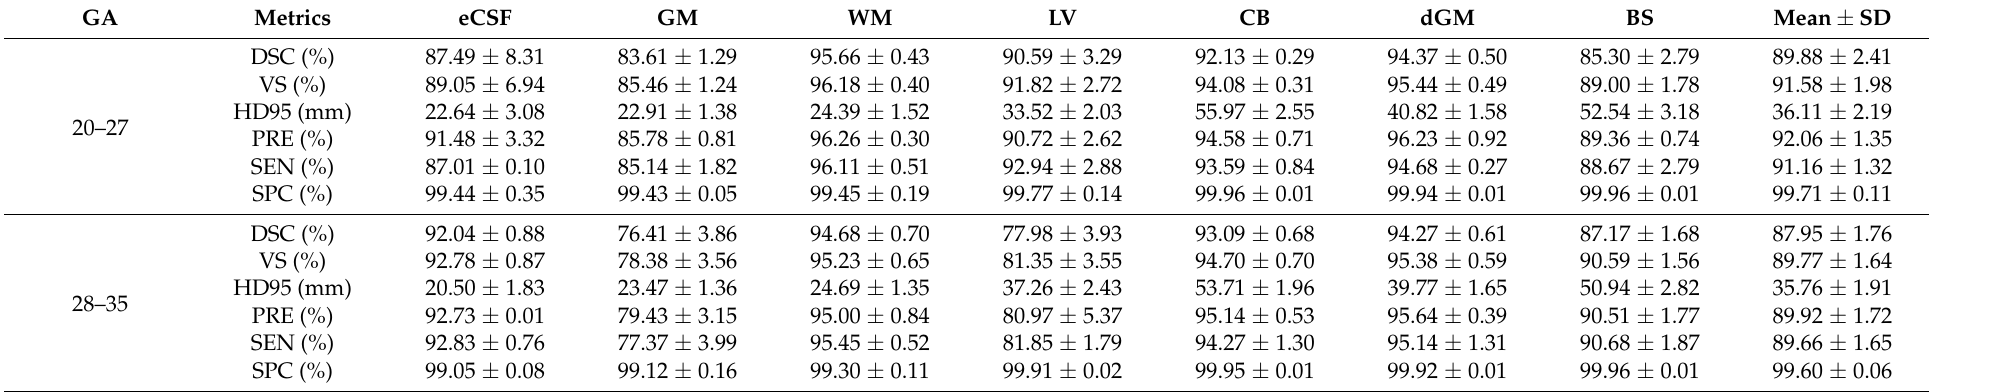
Table 3. Comparison of segmentation results of different gestational age groups (20–27 weeks and 28–35 weeks) based on quantitative performance metrics (DSC, VS, HD95, PRE, SEN,